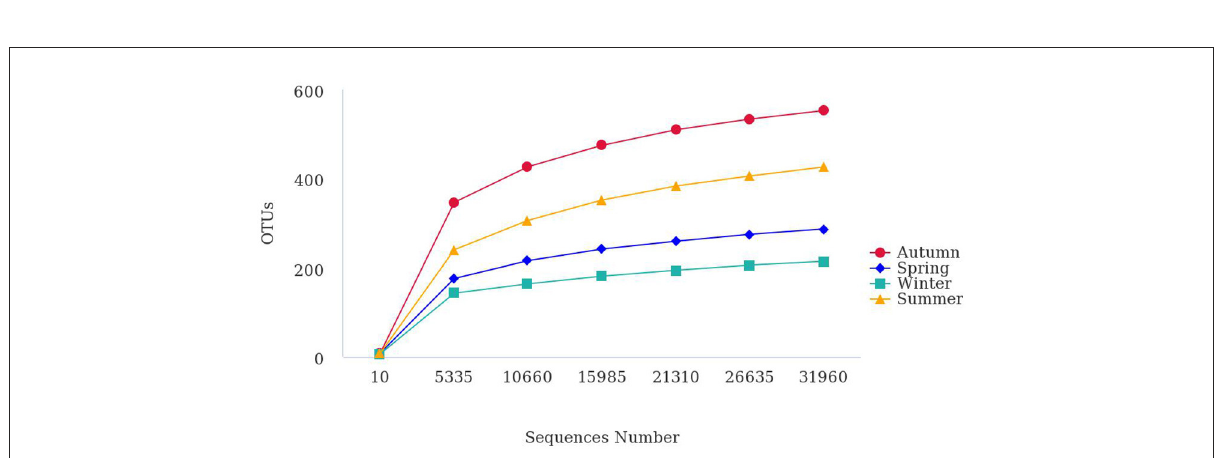
FIGURE2 Rarefaction curves describe the bacterial OTU richness in the bioaerosol during different seasons. Diversity indices were calculated using random selections of 31,960 sequences per